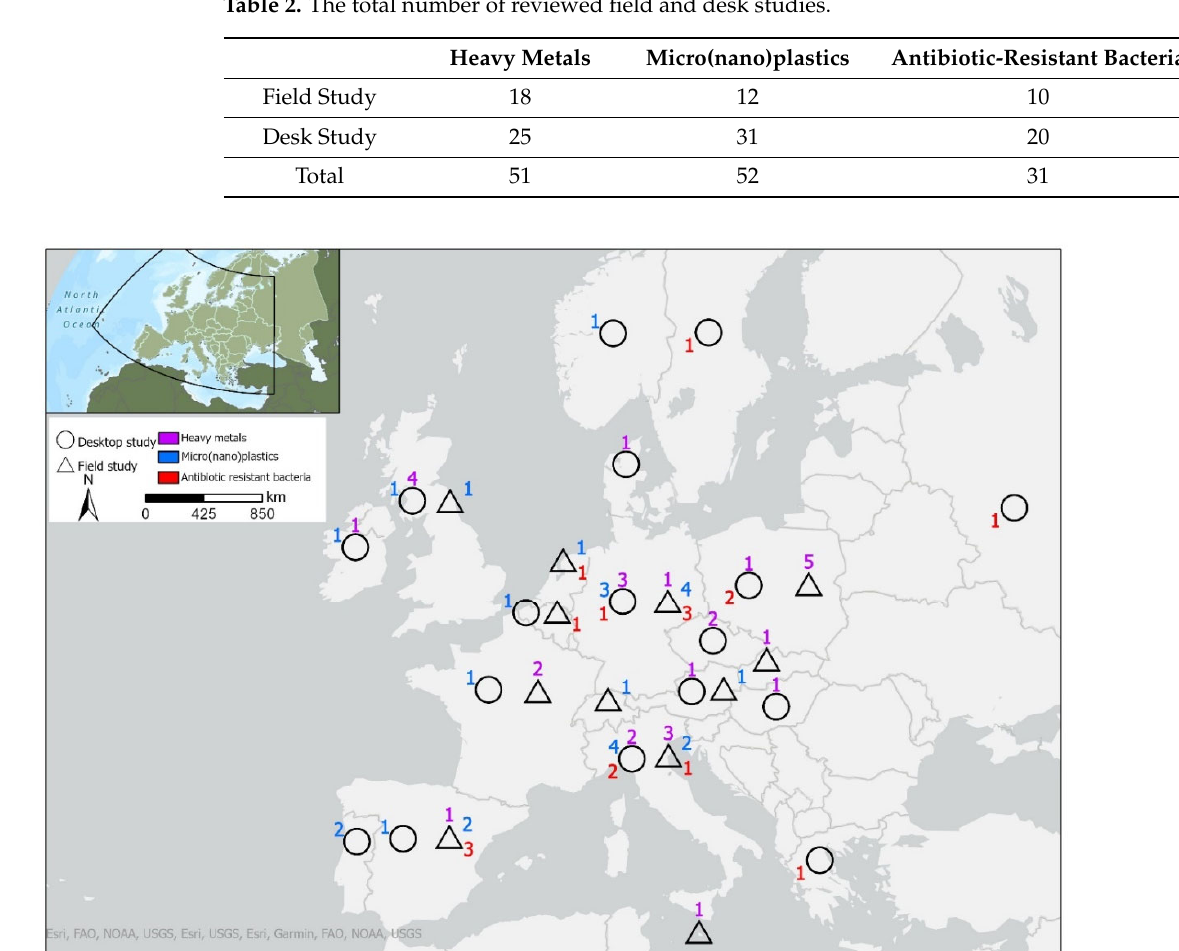
Table 2. The total number of reviewed field and desk studies .